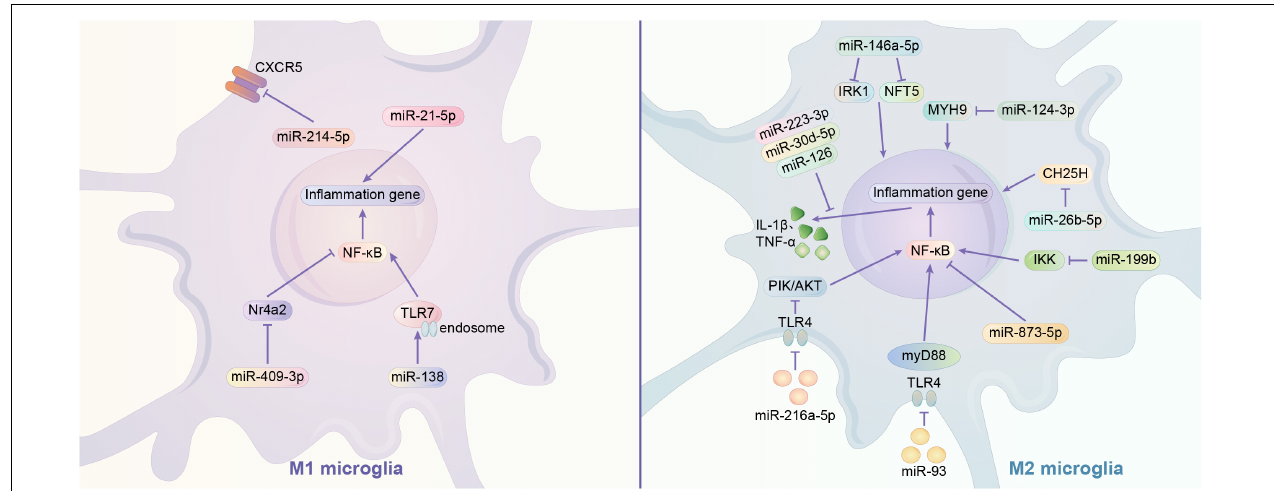
FIGURE 1 | Regulation mechanism of miRNA on microglia polarization. (1) Signaling pathway of M1 polarization regulated by miRNA. miR-21-5p acts on microglia through releasing pro-inflammatory substances, while miR-214-5p suppress the expression of CXCR5 and other pro-inflammatory substances like IL-6, IL-8, TNF- α . NF- κ B is thought to be a common pro-inflammatory signal pathway. miR-409-3p can downregulate Nr4a2 (a suppressor of NF- κ B) to activate microglia. MiR-138 may activate the TLR7 to promote NF- κ B. (2) Signaling pathway of M2 polarization regulated by miRNA. The exosomes containing miR-223-3p, miR-30d-5p, or miR-126 may suppress the synthesis of inflammatory factors to inhibit the activation of microglia. There is some genetic expression may influence the polarization of microglia.miR-146a-5p may downregulate IRK1 and NFT5 to inhibit the activation of microglia. MiR-124-3p may suppress the expression of MYH9.miR-26b-5p may suppress the expression of CH25H. miR-873-5p may suppress the NF- κ B signaling pathway, which is very common in inflammation. All these three miRNA can inhibit microglia polarization. TLR4 signal pathway is a common way to promote inflammation, while the inhibition of it can suppress the process. Exosomes of miR-93 may suppress the NF- κ B signaling pathway through downregulating TLR4 expression. Similar exosomes of miR-216a-5p may activates the PI3K/AKT signaling pathway and the expression of NF- κ B through the downregulation of TLR4 to promote the M2 microglia. IKK is a stimulators of NF- κ B. miR-199b may downregulate IKK to inhibit NF- κ B and microglia